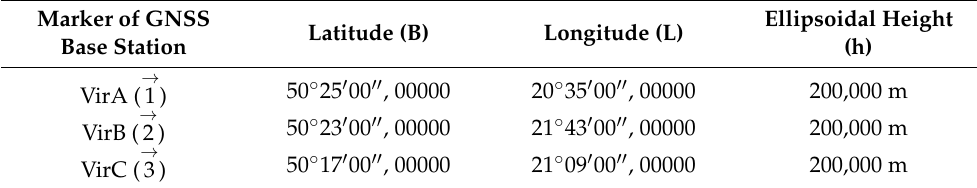
Table 1. The coordinates of GNSS base stations.